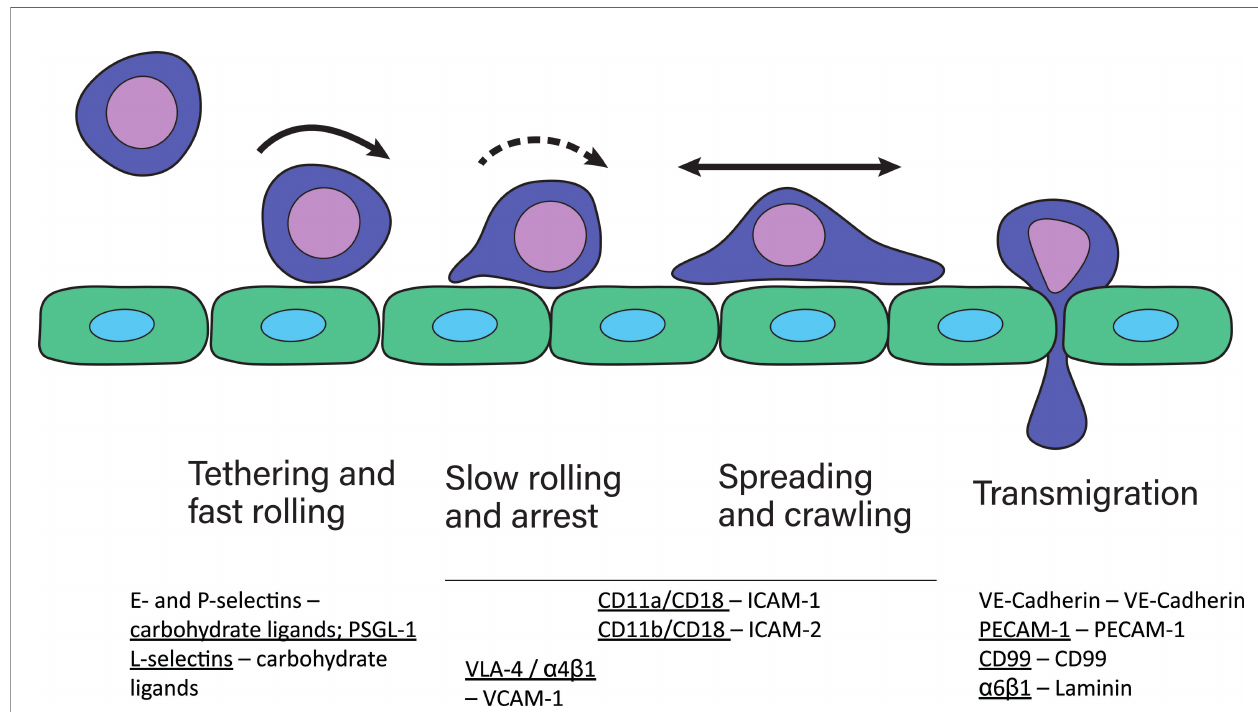
FIGURE 1 | The cell adhesion cascade. During adhesion to and extravasation through the endothelium, leukocytes undergo several steps, namely fast rolling and tethering, slow rolling and arrest, spreading and crawling and lastly transmigration. These steps are mediated by several different adhesion receptors expressed by leukocytes, indicated by underscore, and the endothelium (2). P-selectins and E-selectins expressed by the endothelium bind to their carbohydrate ligands on leukocytes during fast rolling. Leukocytes express L-selectins, which bind to ligands on the endothelium during fast rolling. The most well known selectin ligand is P- selectin glycoprotein ligand-1 (PSGL-1). Selectin-ligand binding results in integrin activation in leukocytes, which then mediates slow rolling, arrest, spreading and crawling. During transmigration, several homophilic adhesion receptors, including VE-cadherins important for tight junctions between endothelial cells, and CD99 and PECAM-1 are expressed by endothelial cells and leukocytes. Additionally, leukocytes express a 6 b 1 integrins that bind to